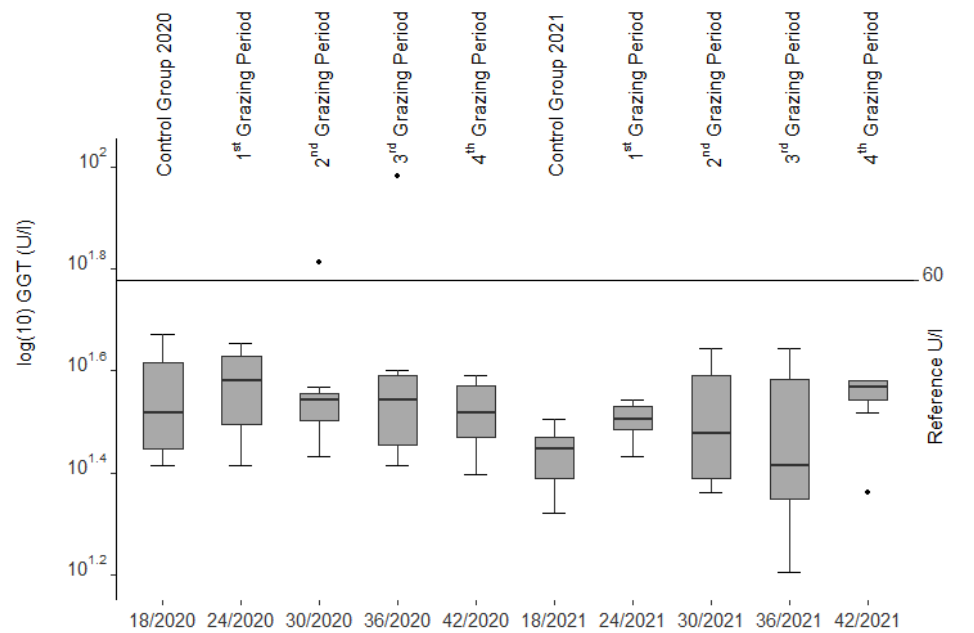
had three cases of minor hemoconcentration (packed cell volume (PCV) > 0.44 L per liter (l/l)) and one animal with a minor case of anemia (PCV < 0.22 l/l) along with leukocytosis (leucocytes 13.7 giga per liter (G/l)).